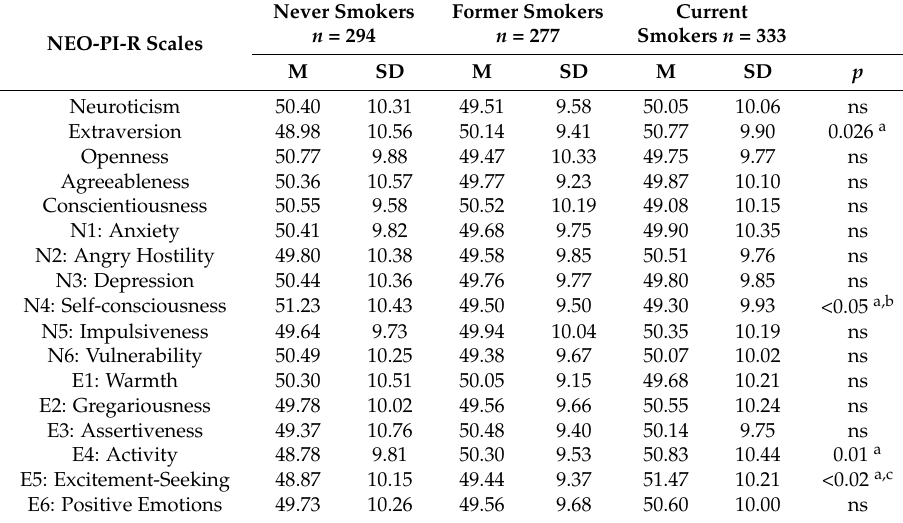
Table 2. Personality traits presented as mean T-scores and standard deviations for never, former and current